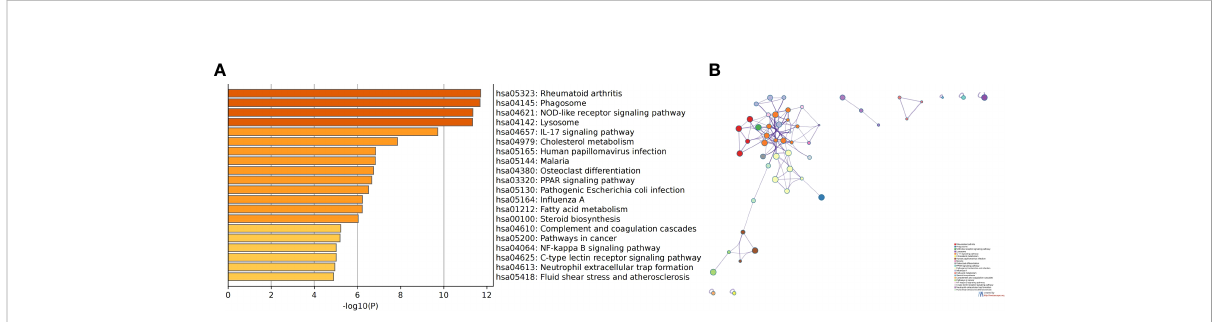
FIGURE 12 The results of KEGG enrichment analysis of DEGs in GSE37356. (A) Bar chart of the KEGG enrichment analysis. (B) Network diagram of the KEGG enrichment